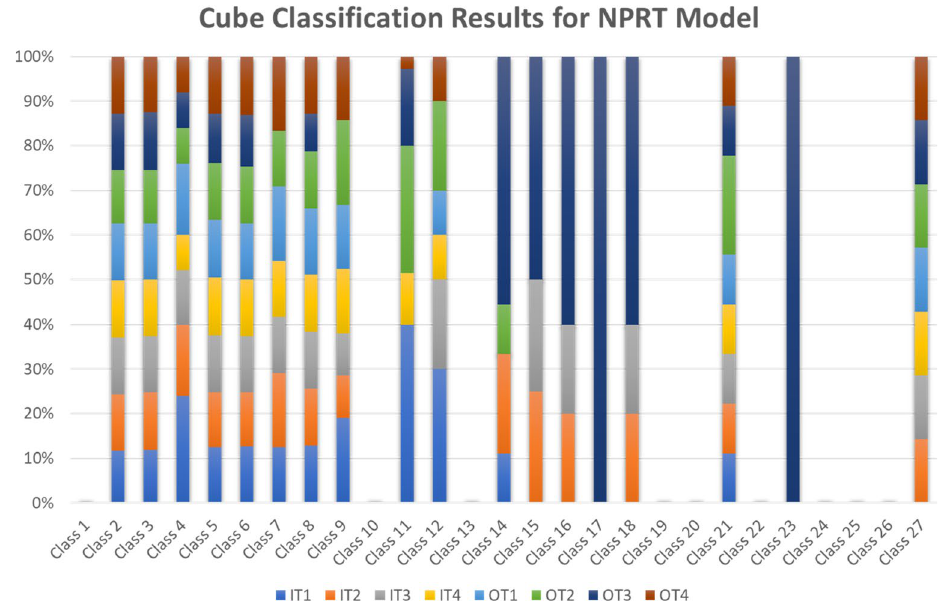
Figure 7. Number of stations in Cube classification method for NPRT